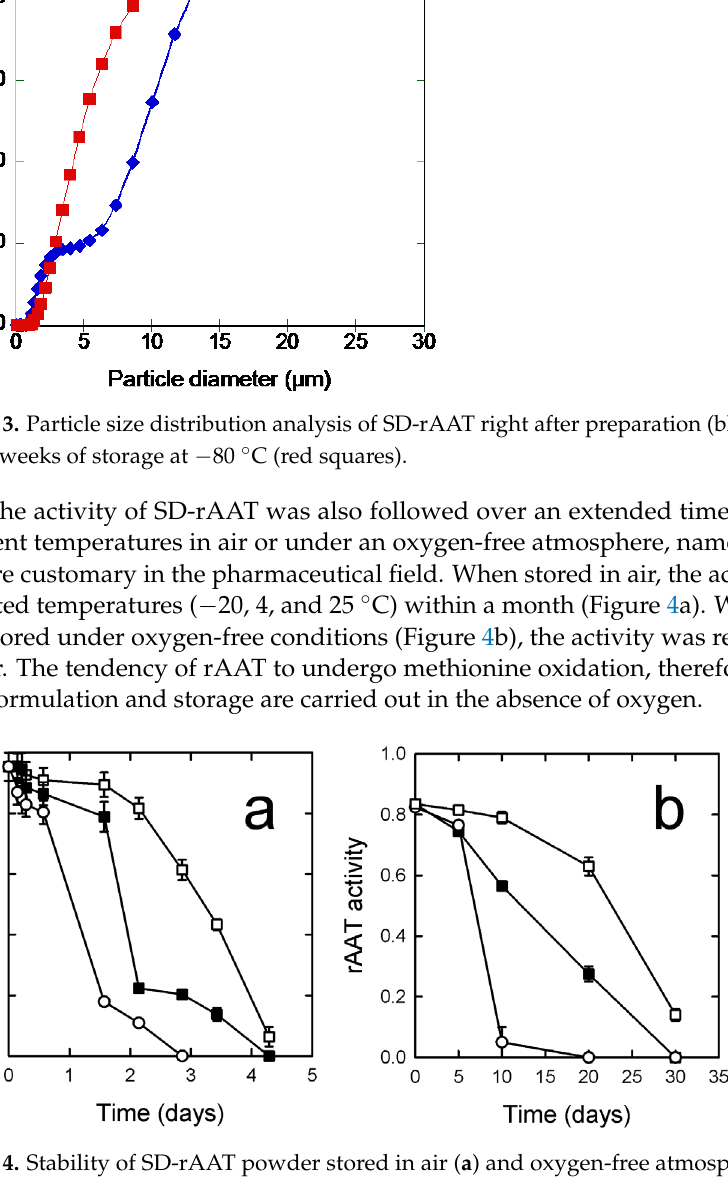
Figure 4. Stability of SD-rAAT powder stored in air ( a ) and oxygen-free atmosphere ( b ) at − 20 ◦ C (open squares), 4 ◦ C (closed squares), and 25 ◦ C (open circles). Data are shown as mean ± SE.